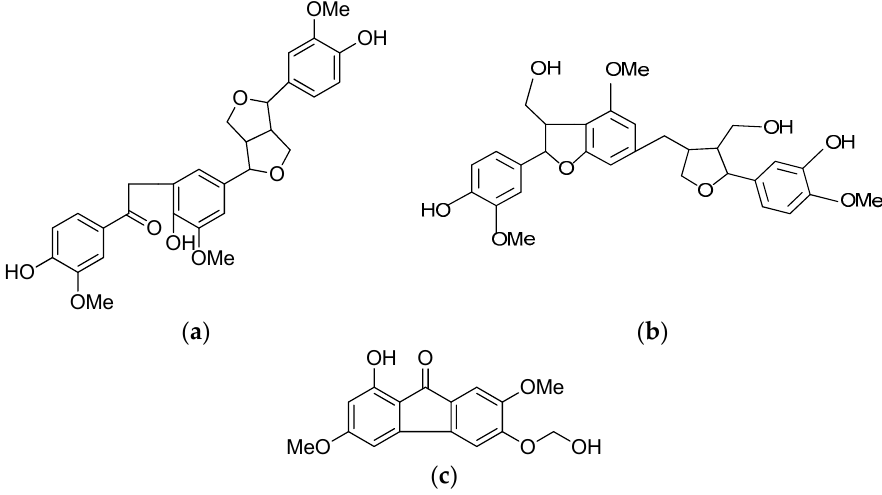
Figure 1. The chemical structures of three lignans isolated from H. caudigerum seeds (HS). The data obtained here were consistent with previous studies. ( a ) Herpetone (HPO); ( b ) Herpetin (HPT); ( c ) Herpetfluorenone (HPF).